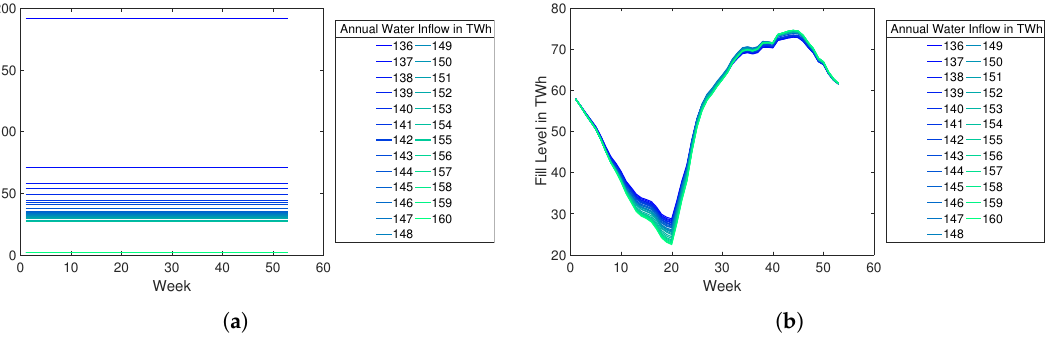
Figure 3. Impact of different yearly water inflows in a deterministic model. ( a ) price alteration in a deterministic model with different amounts of water inflow; ( b ) fill level alteration in a deterministic model with different amounts of water